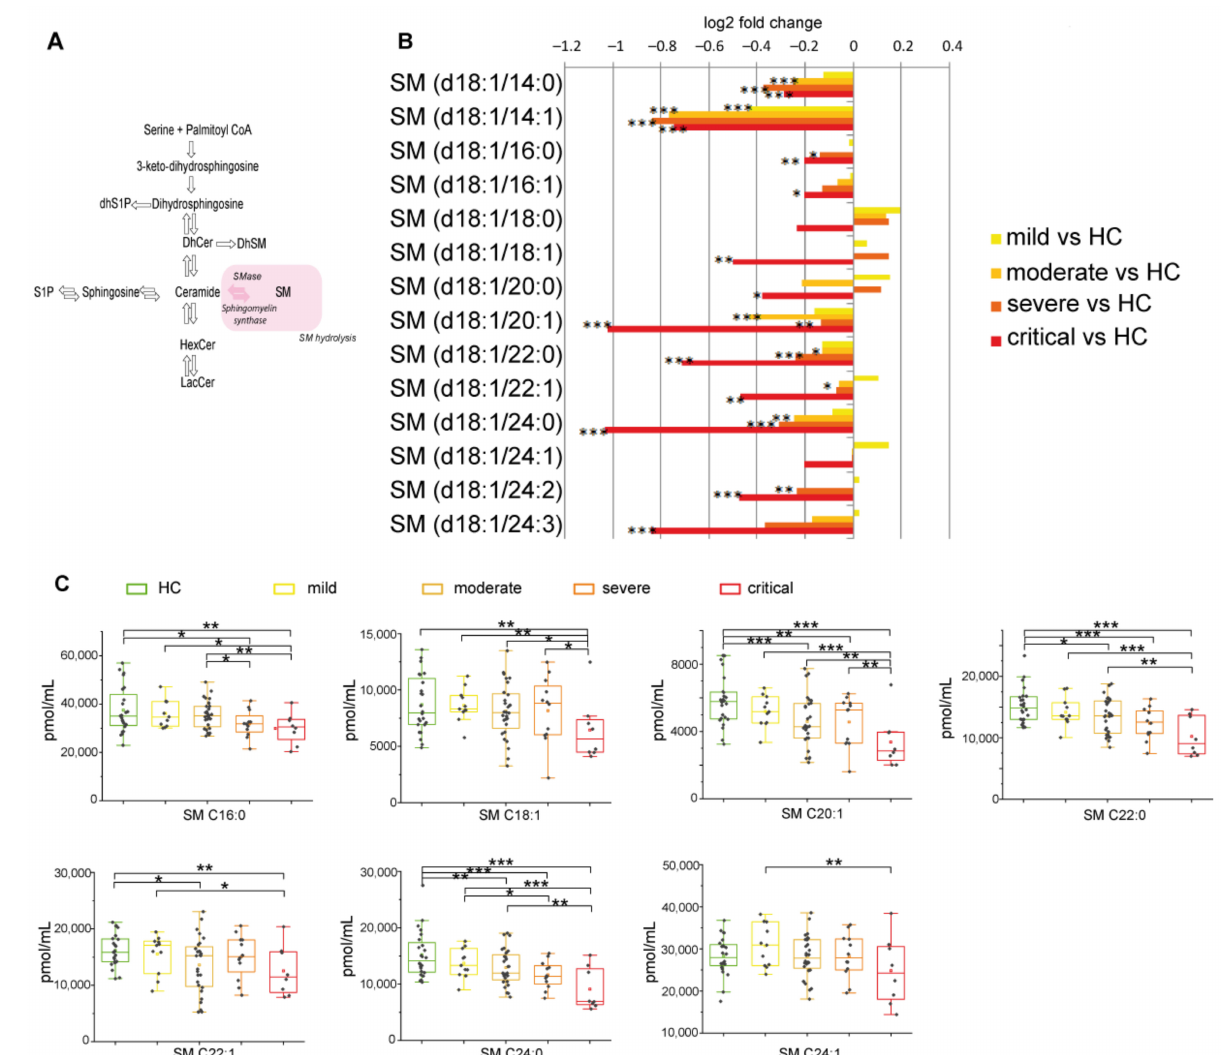
Figure 5. ( A ) Serum sphingolipid changes related to COVID-19 in the sphingomyelinase pathway, highlighted in pink. ( B ) Log 2 fold changes of the median values of SMs (C14:0, C14:1, C16:0, C16:1, C18:0, C18:1, C20:0, C20:1, C22:0, C22:1, C24:0, C24:1, C24:2, C24:3) in COVID-19 severity groups vs. healthy controls (HC). ( C ) Box plots of serum SM species changed according to COVID-19 severity (C16:0, C18:1, C20:1, C22:0, C22:1 C24:0, C24:1). Each measurement was performed in triplicate. Data were analyzed using Kruskal-Wallis ANOVA, followed by Dunn’s post hoc test for multiple comparisons. * p -value < 0.05, ** p -value < 0.01, *** p -value <